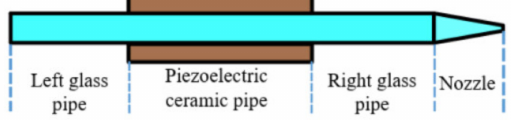
Figure 1. Structure of the squeeze-mode